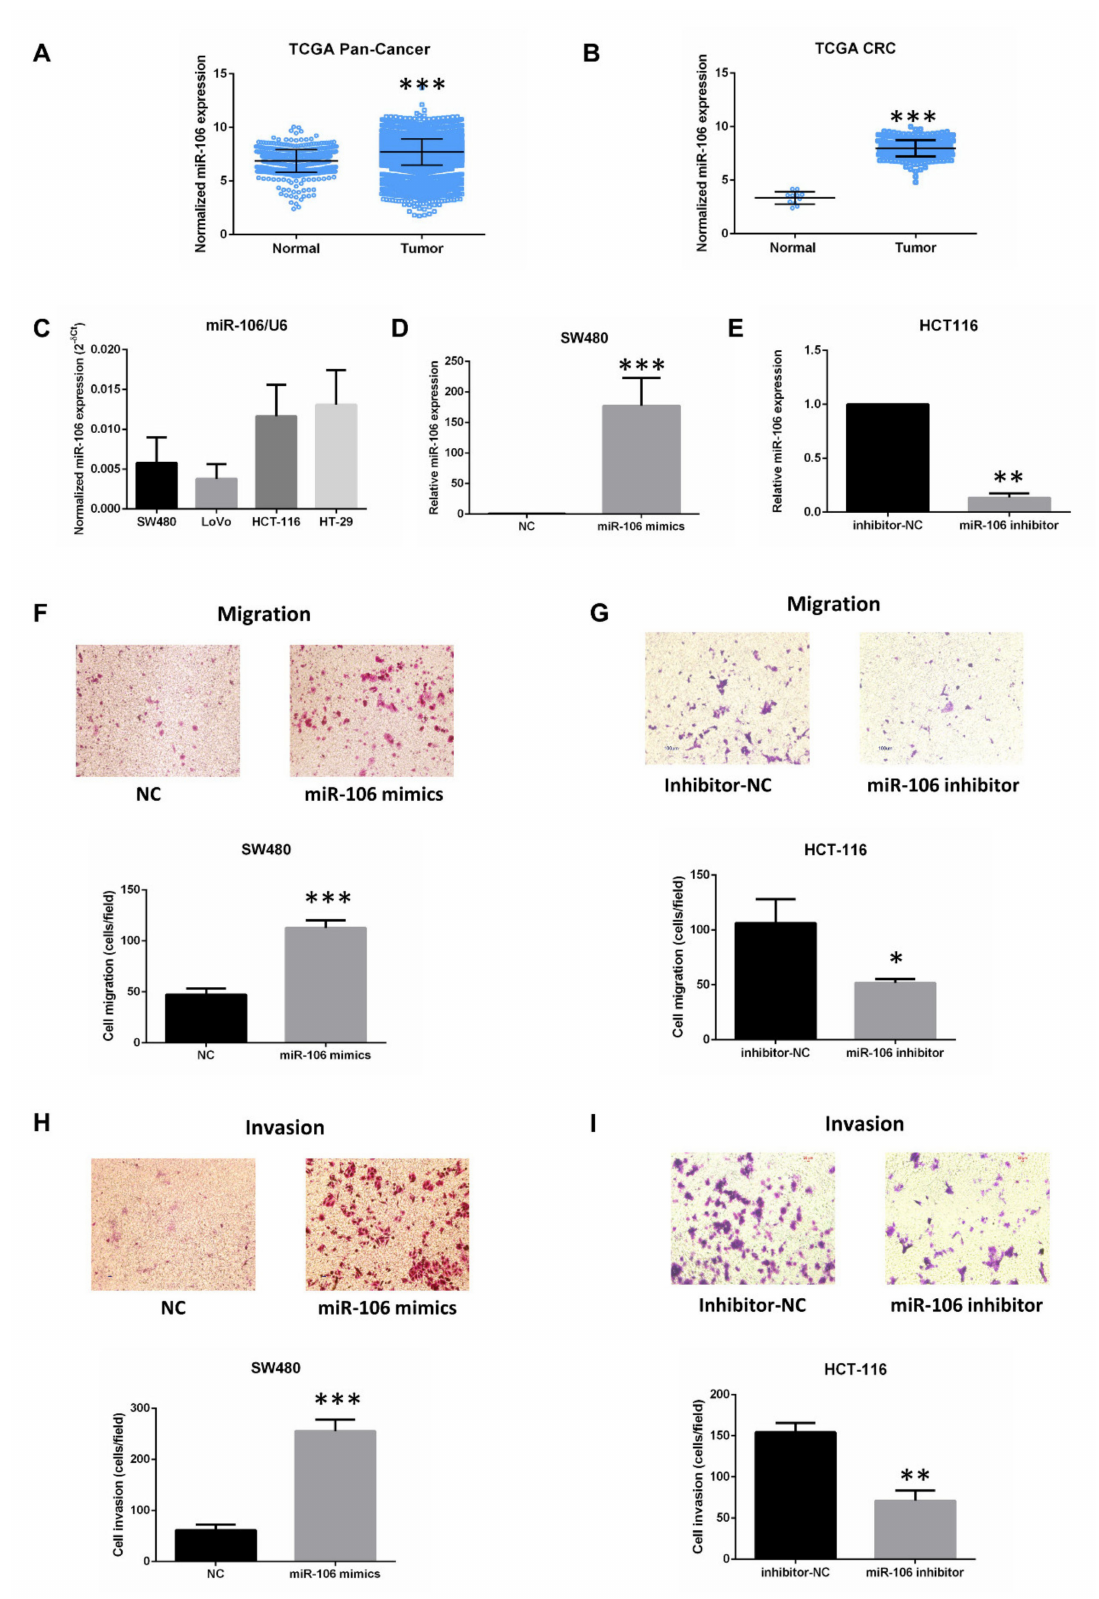
Figure 1. MiR-106b promotes CRC cell migration and invasion. ( A , B ) MiR-106b expression analysis in Pan-Cancer and CRC from TCGA dataset. ( C ) The levels of miR-106b in 4 CRC cell lines were analyzed by qPCR. U6 served as an internal control. ( D ) Transfection efficiency of miR-106b mimics in SW480 cells was analyzed by qPCR. ( E ) Transfection efficiency of miR-106b inhibitor in HCT-116 cells was analyzed by qPCR. The data were normalized to U6 and were expressed as